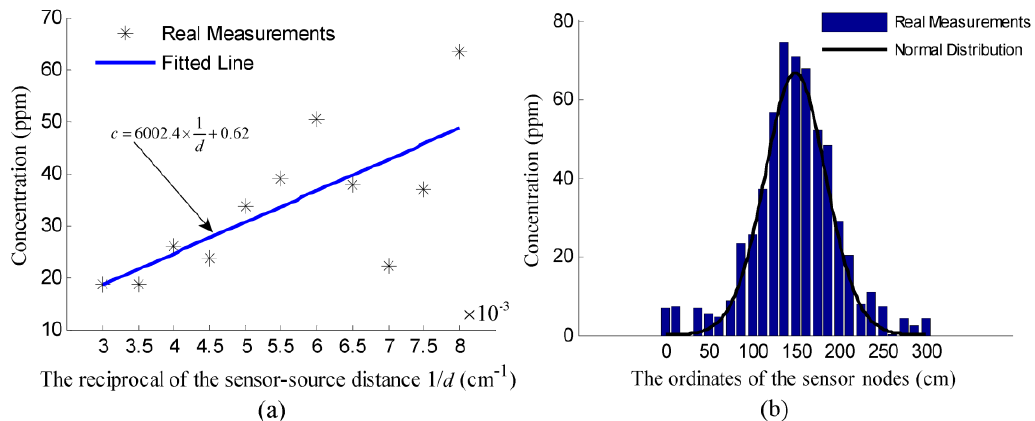
Figure 12. The experiment results of identifying q and K . ( a ) the measurements collected along the centerline of the plume were fitted to a line, of which the gradient can be (2 ) q  considered as 0 . ( b ) the measurements along the line vertical to the plume K centerline. The mean and standard deviation of these measurements were considered as the parameters for generating the normal